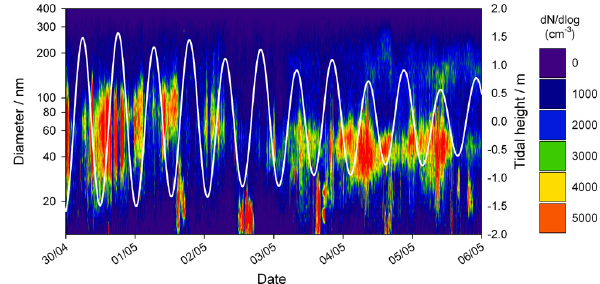
Fig. 3. SMPS observed particle distribution throughout the cam- paign. Classic “banana” shaped particle growth curves were not observed, with the maximum diameter for particle bursts ranging between 14–25nm and the particle bursts were observed only dur- ing low tide day time